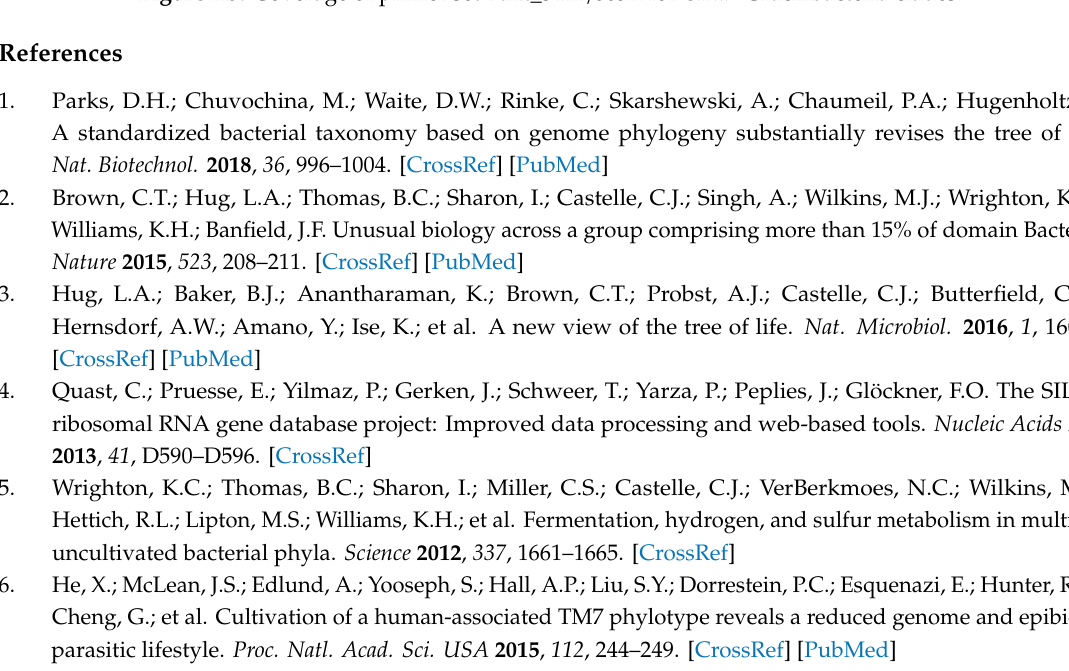
Figure A3. Coverage of primer set Bakt_341F/805R for Cand. Gracilibacteria clades.